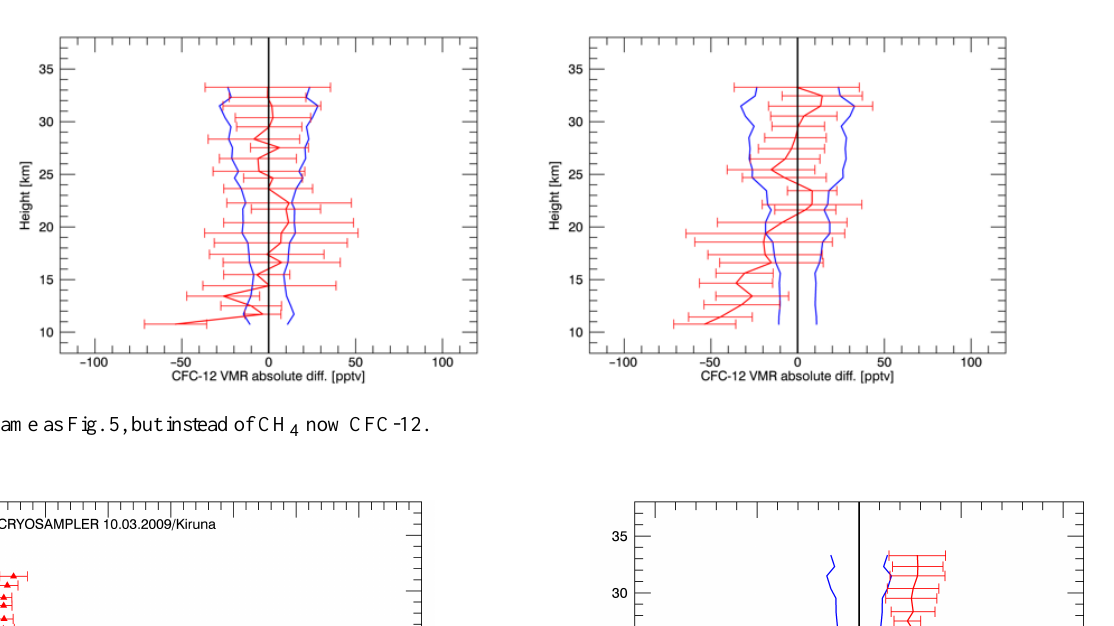
Figure 12. Same as Fig. 4, but instead of CH 4 now CFC-12.